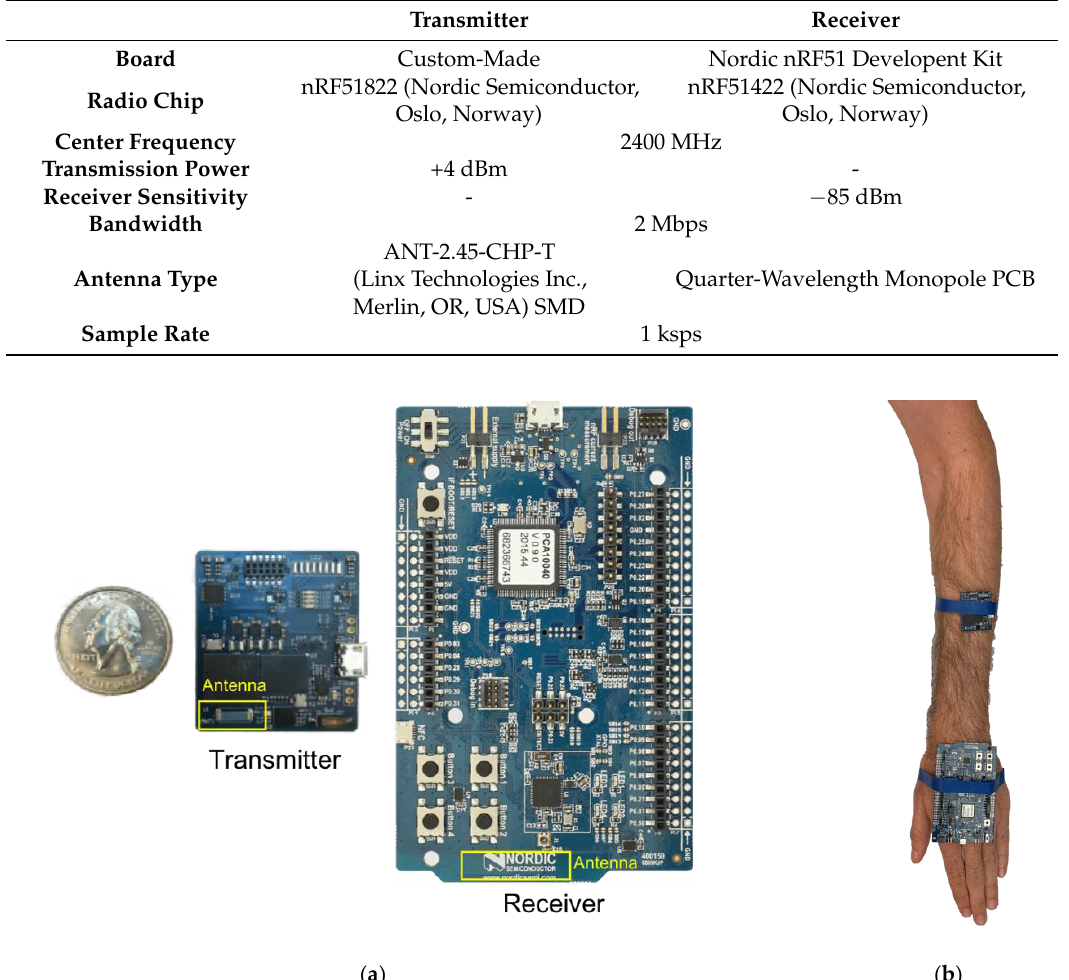
Figure 5. ( a ) Bluetooth nodes with the transmitter node shown on the left and the receiver on the right. ( b ) Bluetooth nodes measurement setup. ( b ) Bluetooth nodes measurement